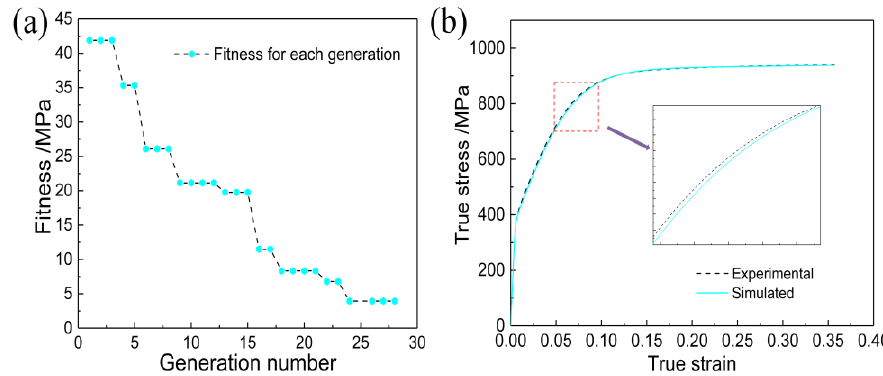
Figure 8. Flow chart of material parameter identification based on PSO (Particle swarm optimization).